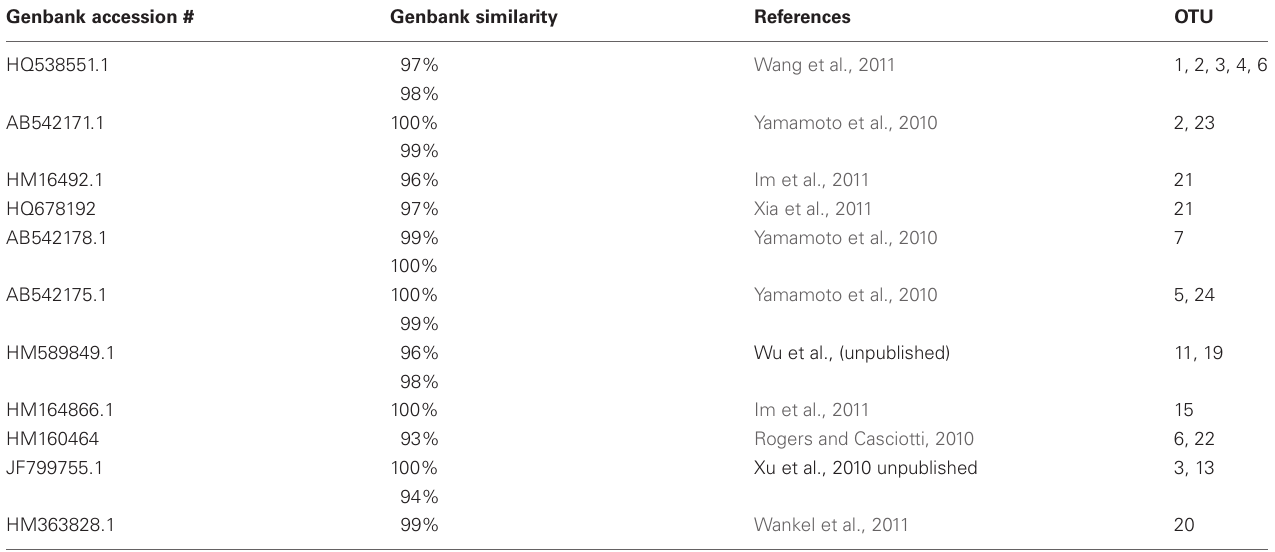
Table A3 | Genbank accession numbers and similarity to mesophilic sequences and